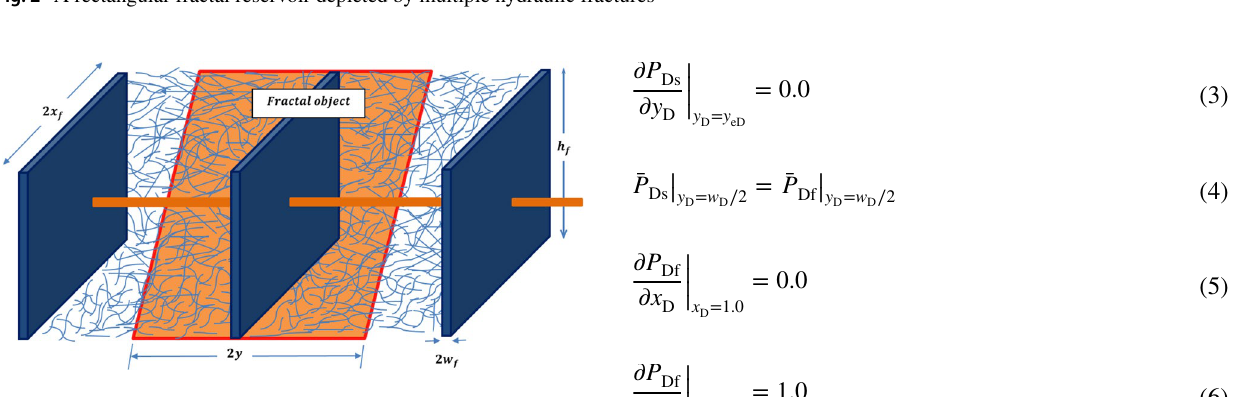
Fig. 2 A rectangular fractal reservoir depleted by multiple hydraulic fractures